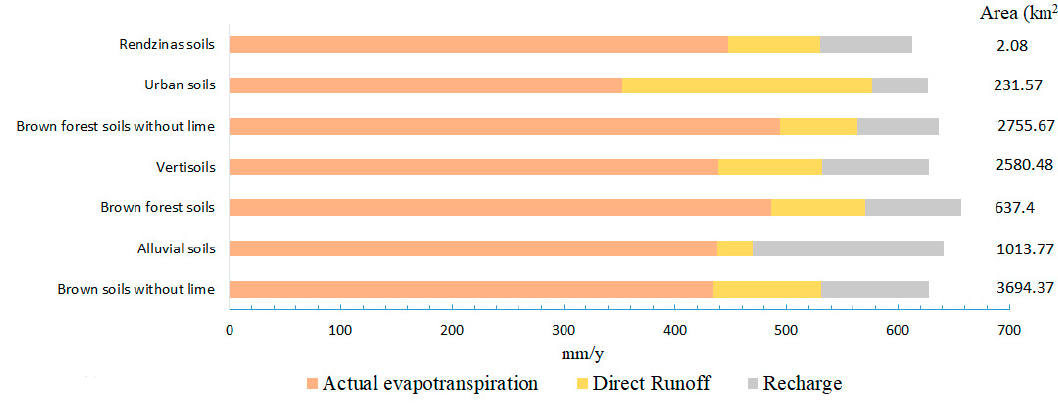
Figure 9. Average annual water budget quantities in terms of soil groups in the Ergene catchment.